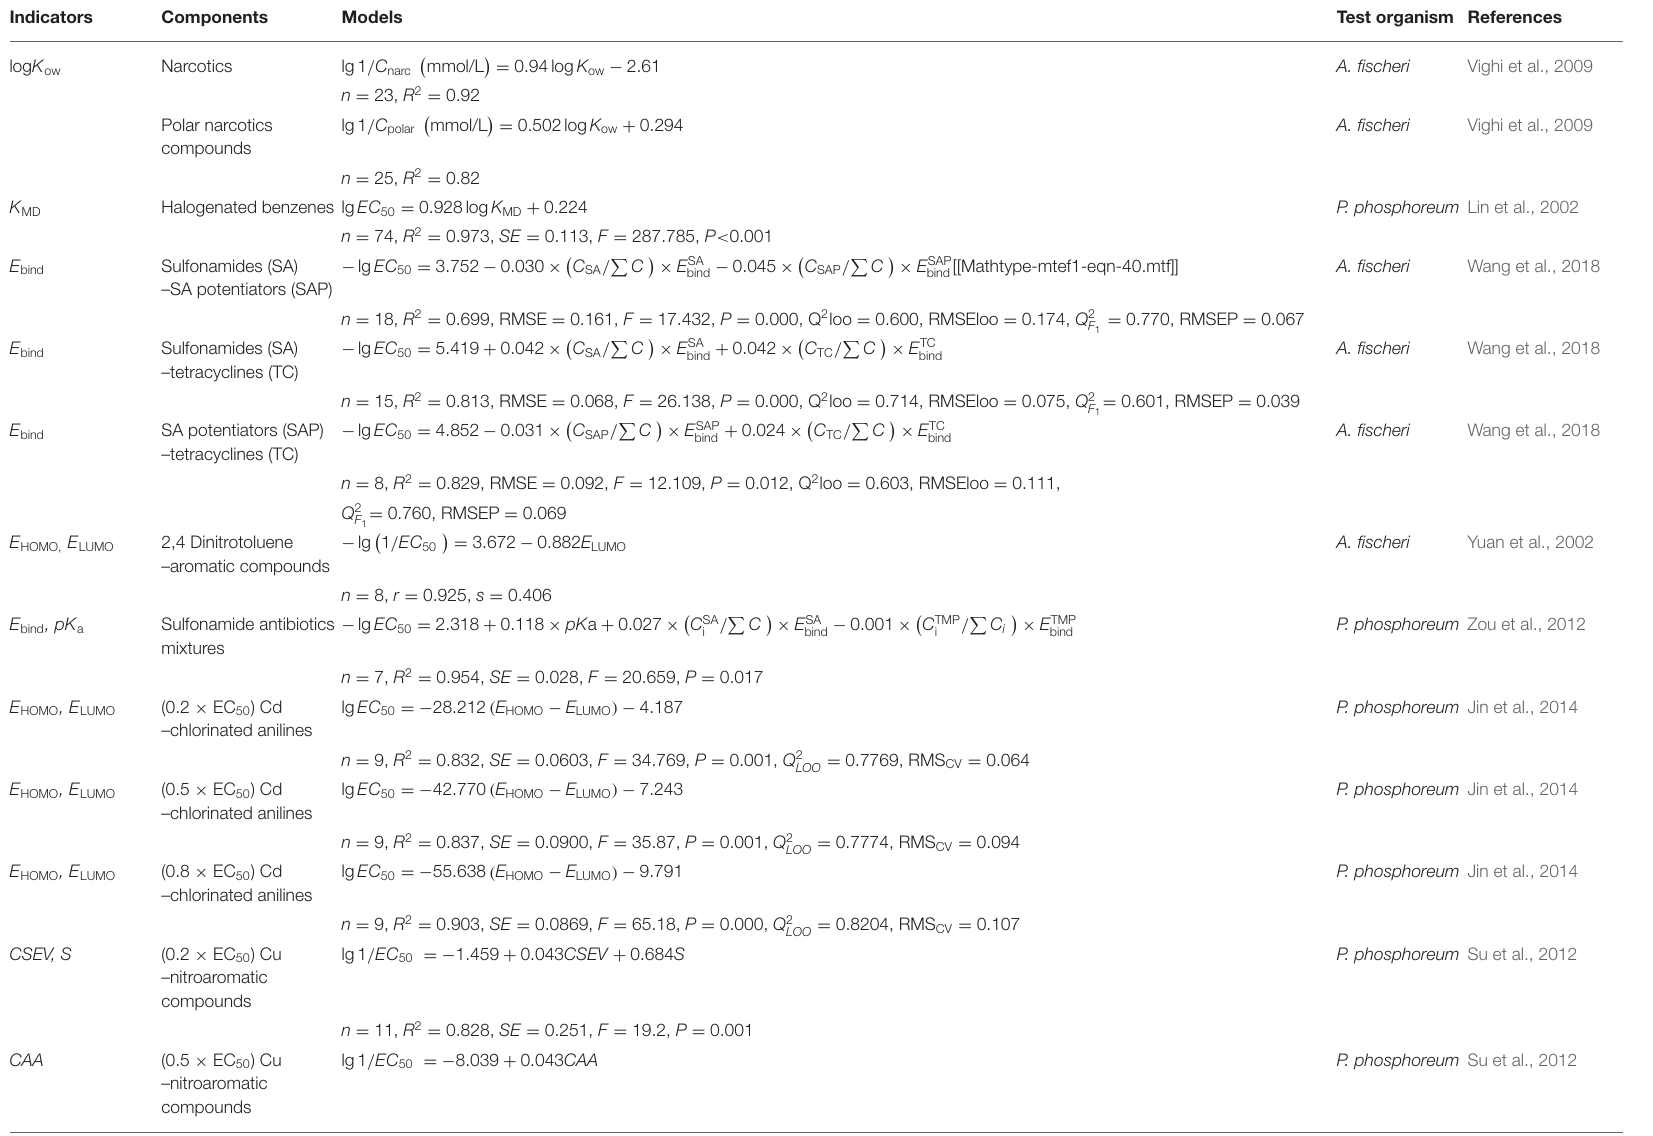
TABLE 4 | Characterizations of various types of QSAR models for prediction of joint toxicity.